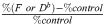
Functional measurement of HLA-F and KIR3DS1 interaction.PBMC from three donors were activated and stimulated with refolded HLA-F, HLA-control tetramers, or no protein as described in Materials and Methods. (A) A representative FACS staining for the analysis of CD107a expression on cell populations gated in the top panel indicated as KIR3DS1+ and KIR3DS1-. Expression of CD107a was detected with percentages of the total cell population analyzed in bold in the lower right quadrant of each profile. Experiments were performed in the presence of HLA-F and Db-TRP bound to streptavidin beads and no-protein as indicated above the panels. The percentages CD107a positive cells within the KIR3DS1+ populations (B) and in the KIR3DS1- population (C) for each donor are graphed for comparison. (B and C) Five experiments were performed for each of four KIR3DS1+ donors (Donors CW and EB: KIR3DL1/KIR3DS1, Donors TG and DG KIR3DS1/KIR3DS1). The graphs show the percentage of total cells using the formula %(ForDb)−%control%control showing the mean of 5 replicates for each individual, the error bars represent the standard error of the mean (SEM) of the replicates, and the p-values calculated by performing a paired t-test comparing all values F and Db across replicates and individuals.